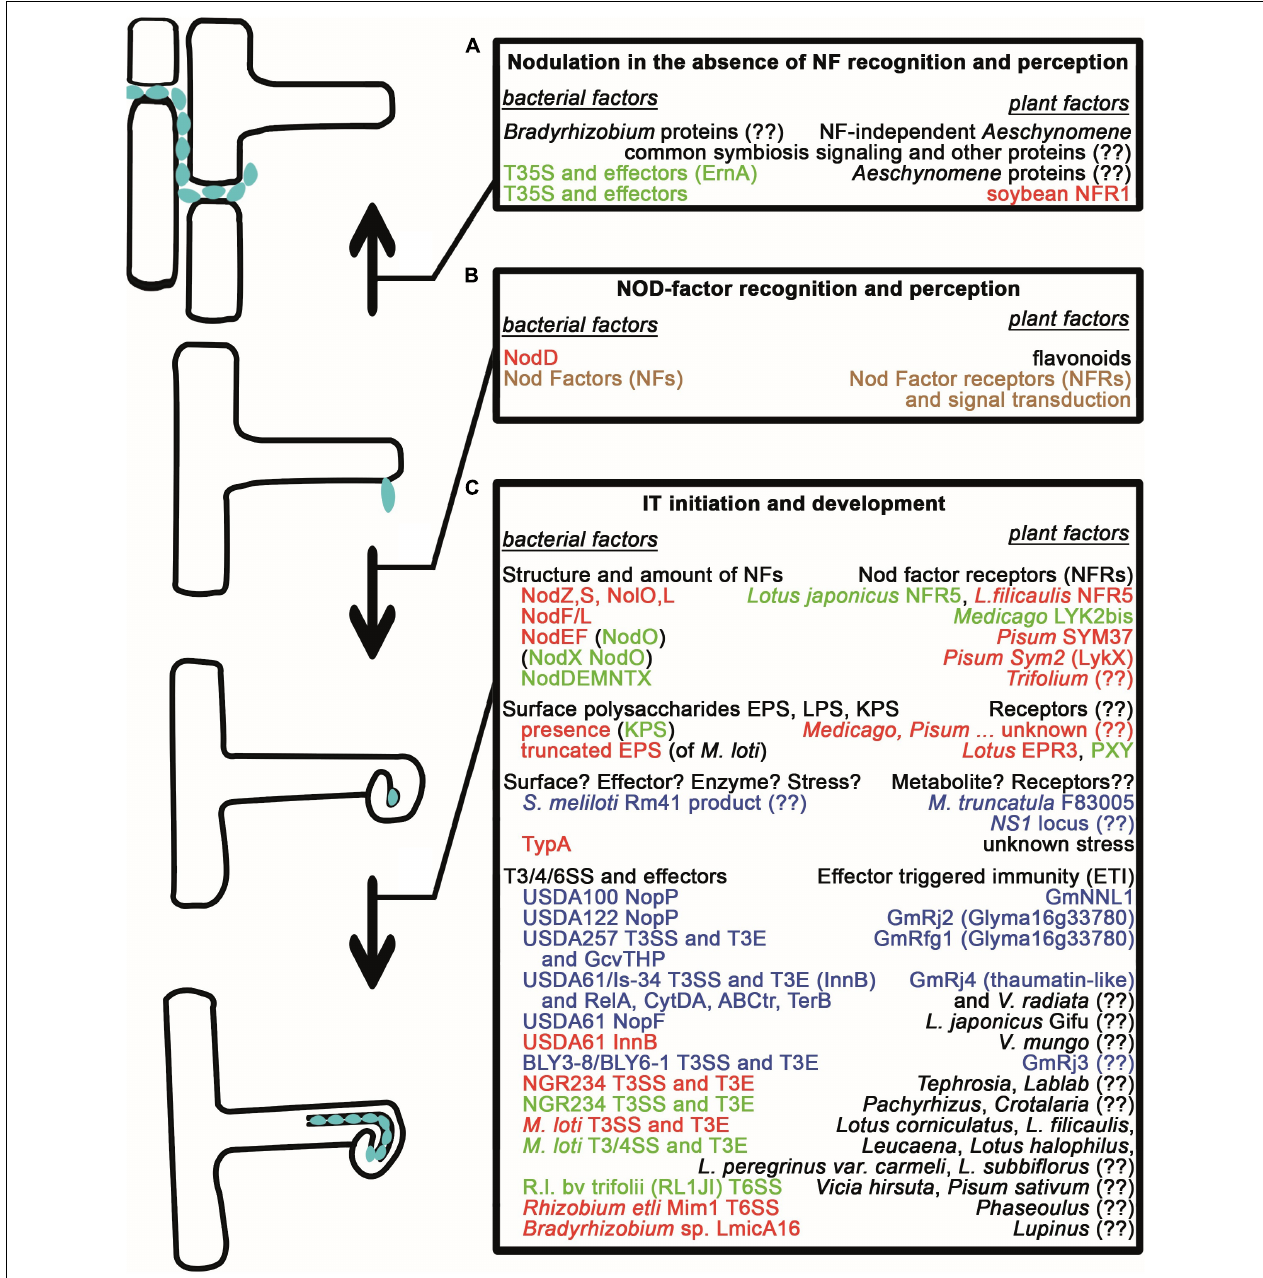
FIGURE 1 | Natural variations affecting early nodule development and infection. (A) Nodule formation and intercellular infection in the absence of Nod factors and NF recognition/perception requires either an unknown mechanism or the activity of Type III secretion systems for the translocation of effector proteins in bradyrhizobia as well as the common symbiosis signaling pathway and other unknown proteins in Aeschynomene species and in soybean plants. (B) Nod Factor production of rhizobia and NF recognition/perception are required for the early symbiotic events such as root hair curling. (C) Initiation and progression of bacterial invasion through ITs are strictly controlled. The structure and amount of NFs determine whether NF receptors allow the initiation of IT development. Similarly, the presence of surface polysaccharides with correct structure is checked by the plants with help of receptors and unknown mechanisms. Unknown mechanisms and stress from the plants also might inhibit infection unless bacteria can deal with them, for example, by expressing the TypA stress protein. Bacterial effector molecules (Nops) resembling pathogen virulence factors transported into the plant cells and Effector Triggered Immunity often led to the restriction of infection, however, there are cases, when they have a positive effect on nodulation. Those bacterial macromolecules, whose lack or incorrect structure led to the arrest of the interaction with certain partners, and those plant proteins, which restrict the bacterial mutants or whose lack can be overturned, are shown in red. Plant molecules, as well as bacterial proteins/molecules, whose lack or presence (in parenthesis), that are able to overturn these defects, are shown in green. Those bacterial and corresponding plant proteins, that are responsible for incompatibility and a defect in either of them leads to compatibility, are shown in blue. If the compatibility needs both the plant and bacterial factors, the proteins are shown in brown. (??) denotes that the given factor has not been identified yet.